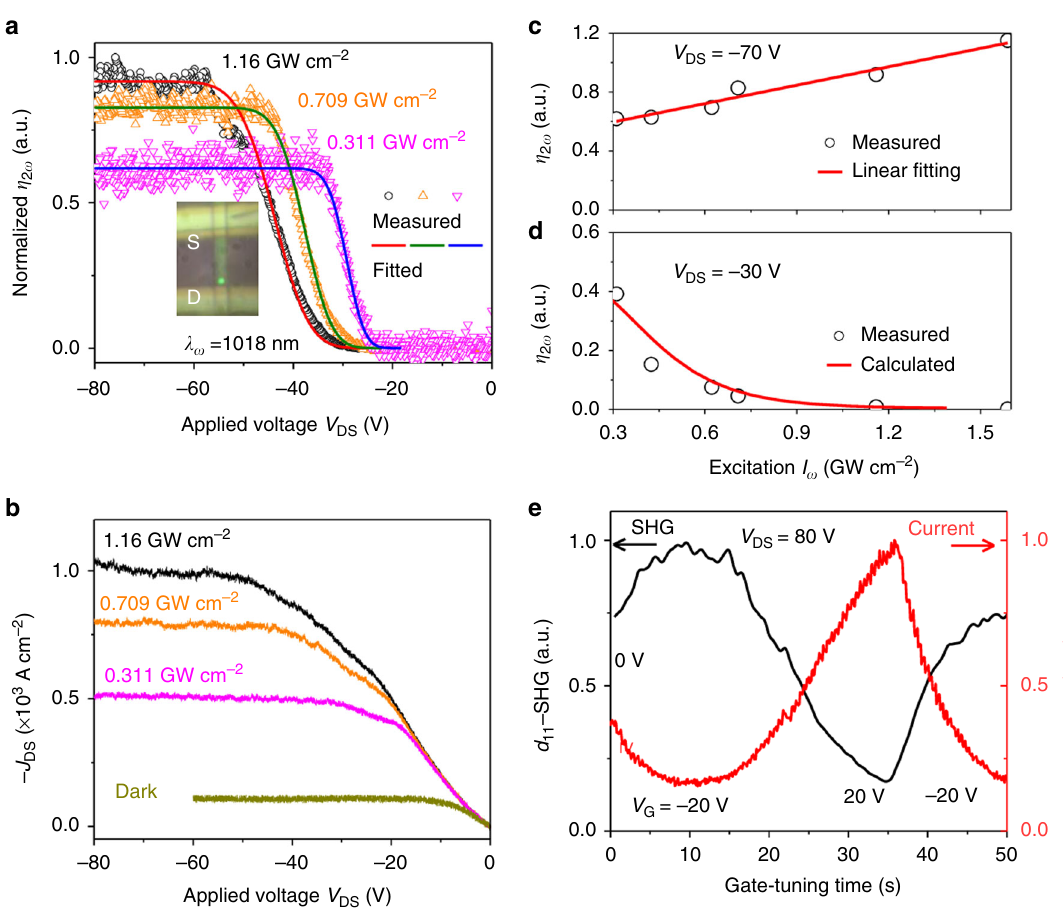
Fig. 4 Near-IR laser intensity and gate voltage-dependence of d 11 -SHG. a Voltage-controlled normalized conversion ef fi ciency ( η ω ¼ P ω = P 2 ω ) of d 11 -SHG under different excitation intensity of the fundamental wave. b I – V curve under different laser excitation intensity. c Near-IR intensity dependence of η 2 ω at − 70 V bias, which is within the saturation region or at which the high- fi eld domain overlaps with the IR excitation region completely (supplementary Fig. 4c). d IR intensity dependence of η 2 ω at − 30 V bias at which only the domain boundary reaches the near-IR excitation region (Supplementary Fig. 4c). The SHG at -30V was also calculated from the fi eld strength of the high- fi eld domain with the experimental excitation intensity and SHG conversion ef fi ciency. More details can be found in Supplementary Note 5. e , Gate-controlled SHG (black curve) and current (red curve). The high- fi eld domain is formed over the near-IR excitation when V DS = 80 V (Supplementary Fig.